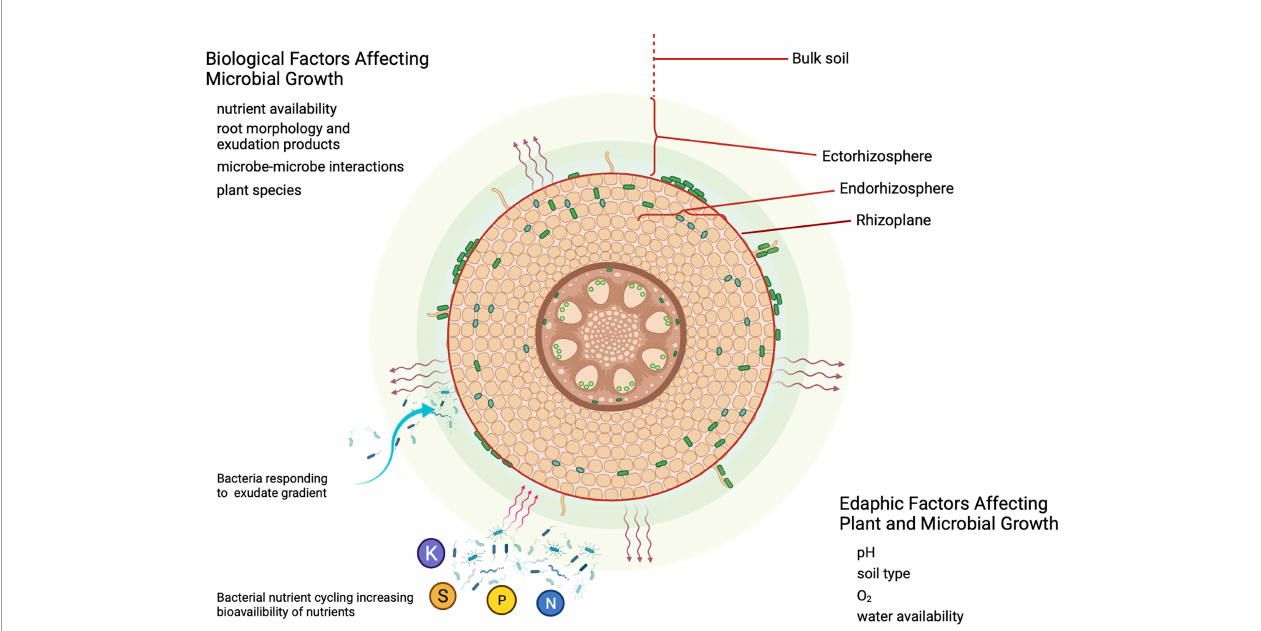
FIGURE 1 | Root rhizosphere and factors affecting microbiome development. A diagrammatic representation of a root cross-section. Factors affecting microbial and plant growth are presented as tables (see text for details). The rhizosphere is depicted as two tones (green and pale yellow) surrounding the root representing an exudation gradient. The endorhizosphere, rhizoplane, ectorhizosphere and bulk soil are highlighted using red brackets, and lines. Endophytic bacteria and bacteria living on the rhizoplane are depicted as green rods. Plant exudation is represented as purple wavy arrows emanating from the root surface. Microbial communities in the rhizosphere are depicted as responding to exudates (single blue wavy arrow), and as bacteria involved in nutrient cycling. Major nutrients are depicted as spheres with letters (N, nitrogen; P, phosphorus; K, potassium; S, sulfur). Wavy tan arrows represent nutrients and/or bacterial factors that bene fi t plant growth. This fi gure was created with